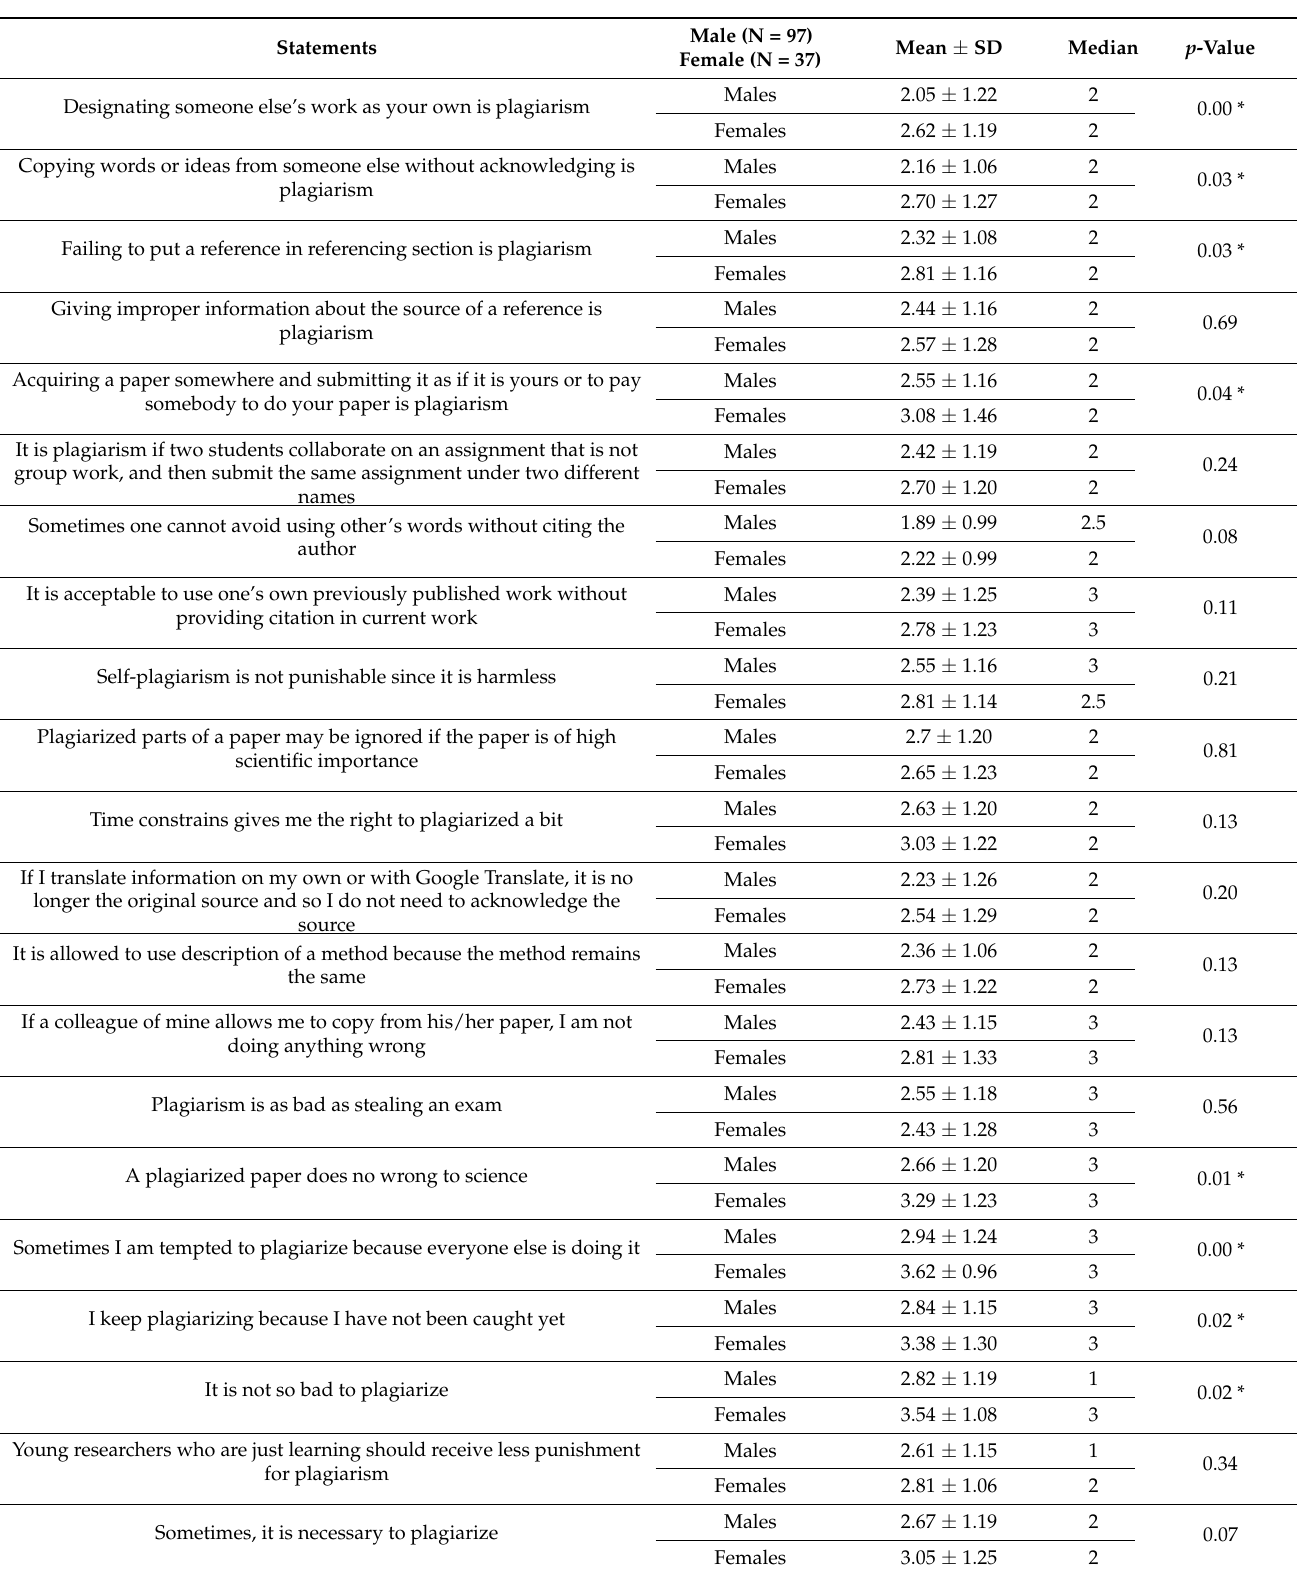
Table 1. Mann Whitney U test results of plagiarism by gender